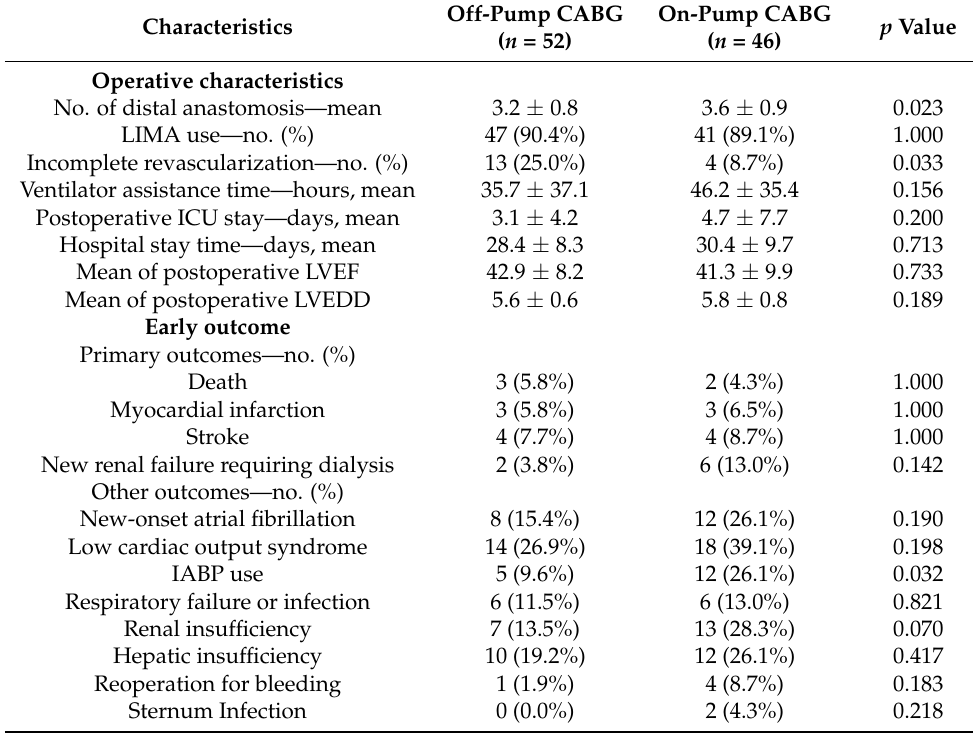
Table 3. Operative characteristics and early outcome of the patients before matching.